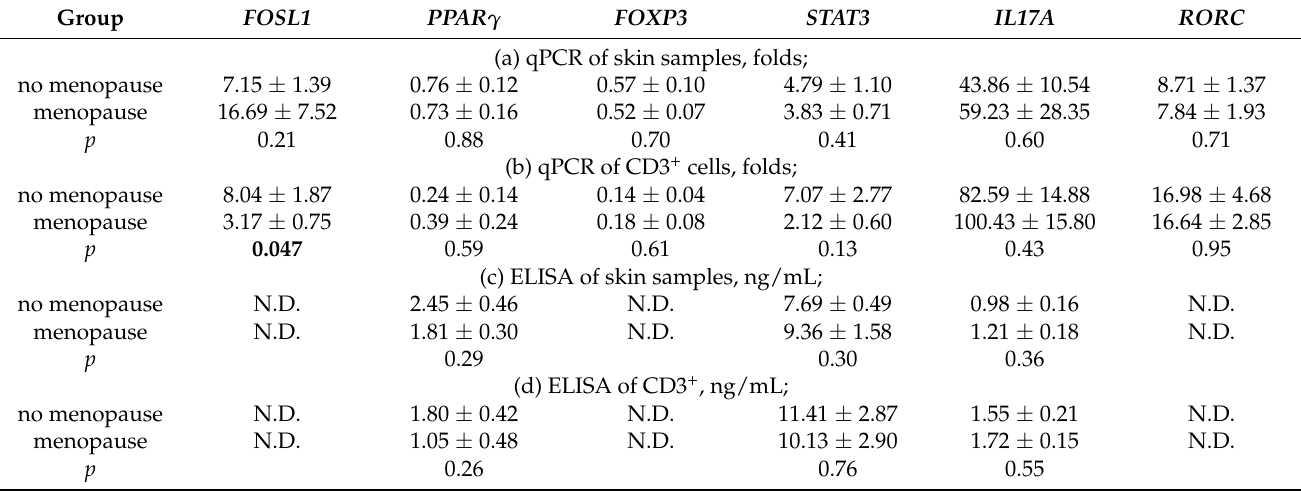
Table 3. Comparative analysis of gene and protein expression in female patients have ( n = 6) and do not have ( n = 7) menopause.